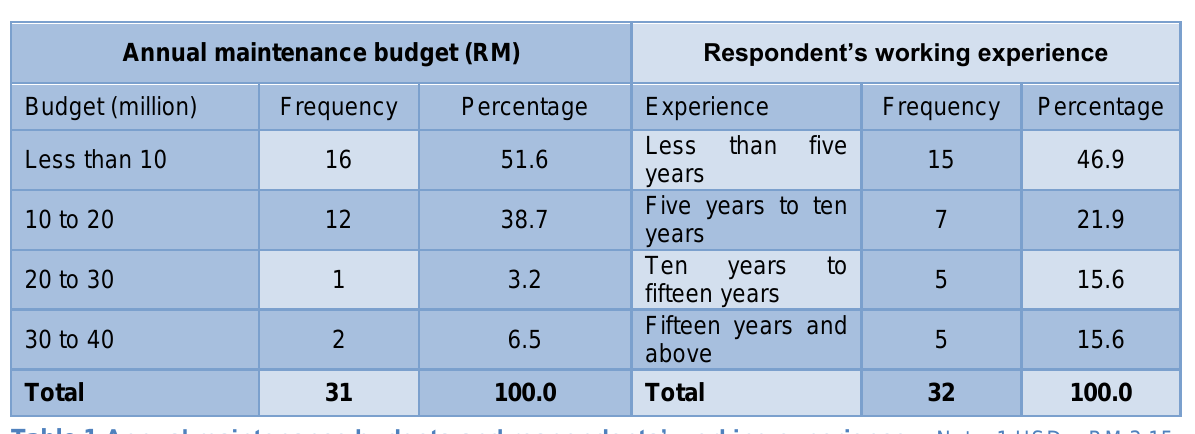
Table 1 Annual maintenance budgets and respondents’ working experience Note: 1 USD = RM 3.15